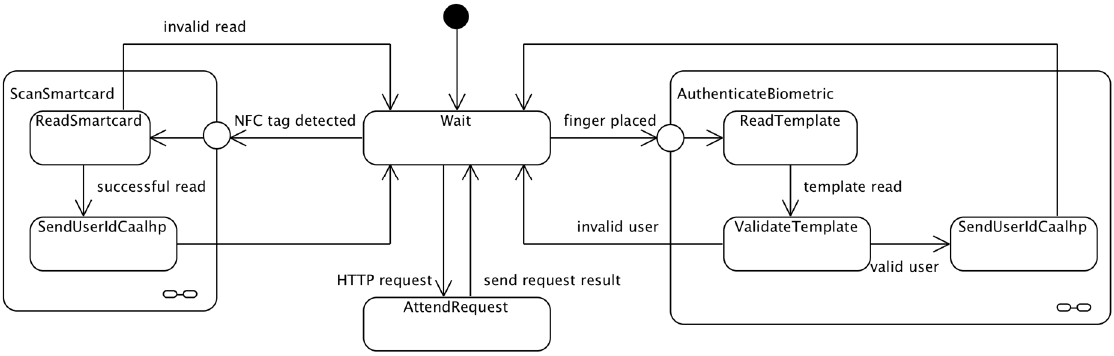
Figure 5. CRIP state machine.